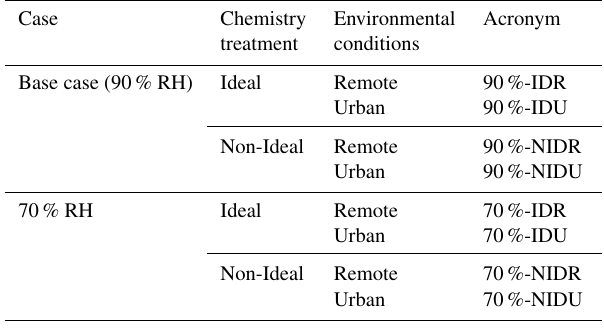
Table 1. List of the microphysical model scenarios and their acronyms used in this study.